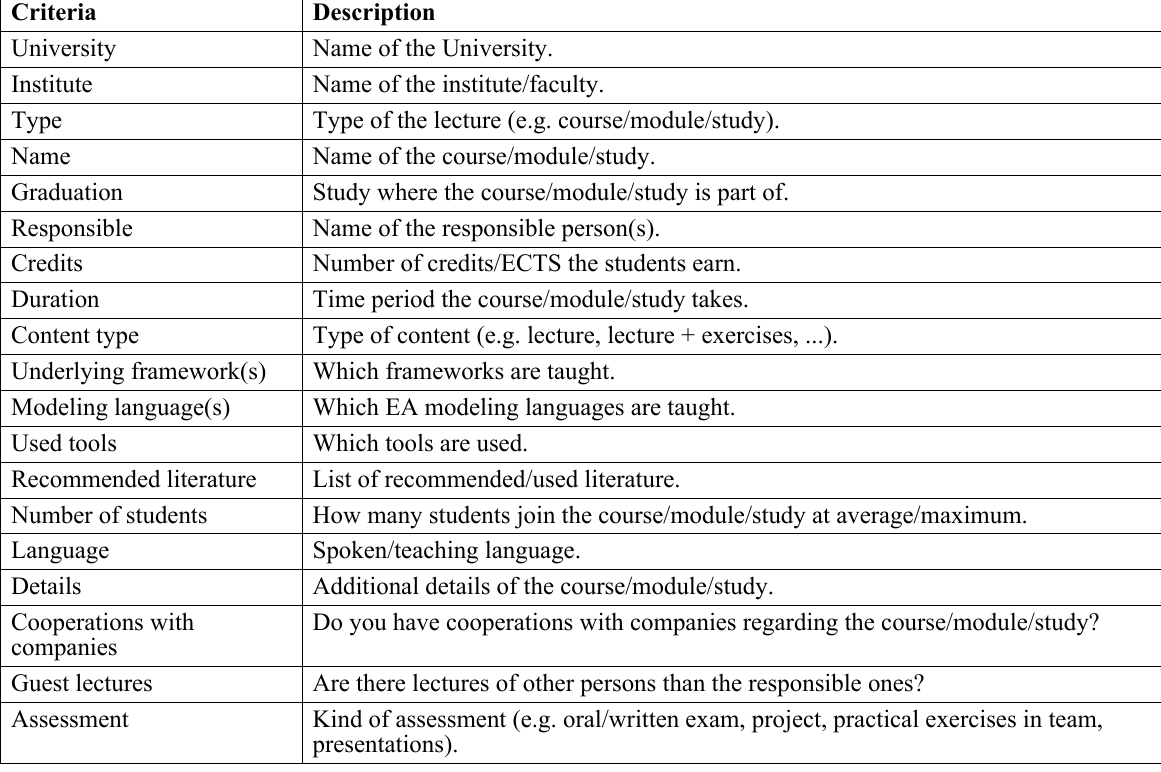
Figure 3. Overview of the assessment process steps Table 1. Assessment frame with short explanation of the assessment